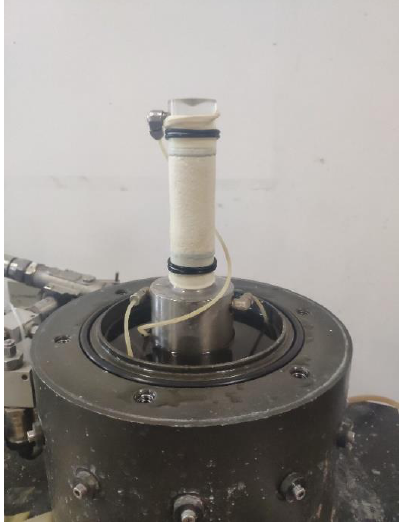
Figure 9. Specimen for drained triaxial compression test.